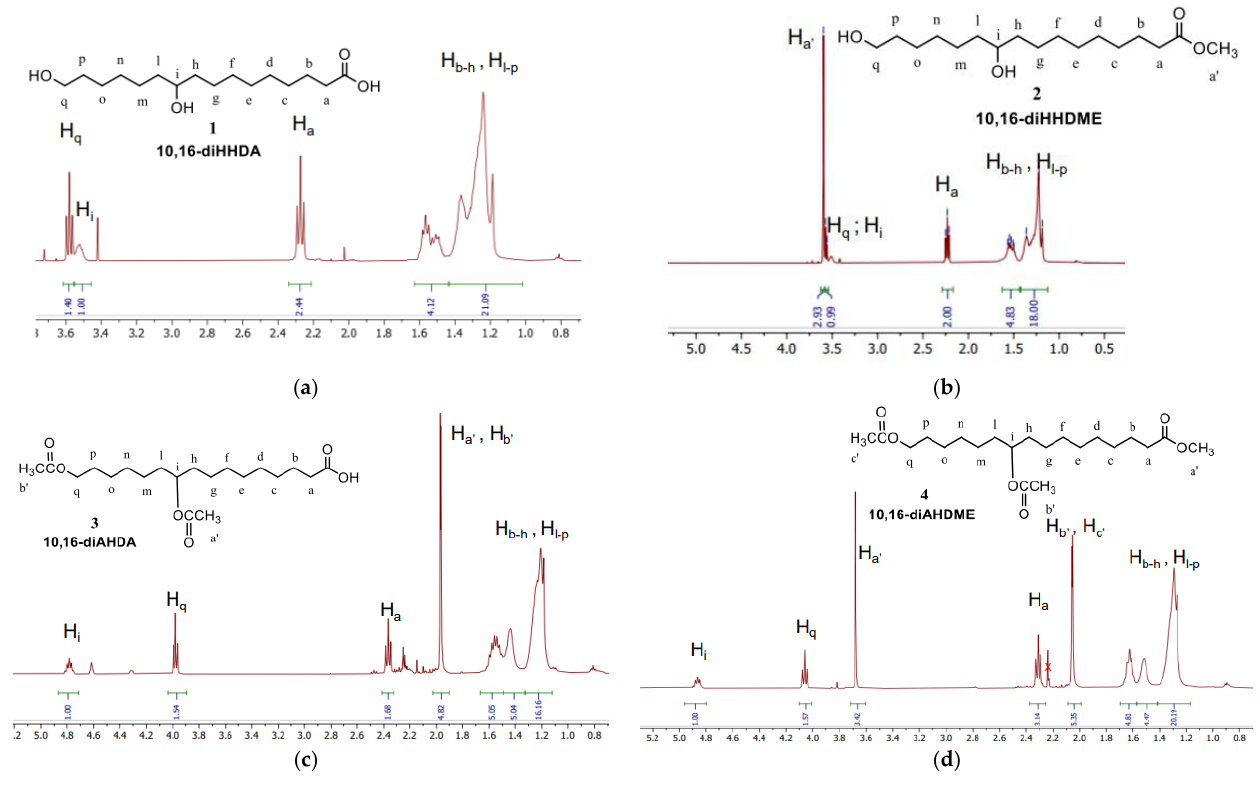
Figure 1. 1 H-NMR spectra in CDCl 3 of the synthesized compounds ( 1 – 4 ): ( a ) 1 H-NMR of 10,16- diHHDA ( 1 ); ( b ) 1 H-NMR of 10,16-diHHDME ( 2 ); ( c ) 1 H-NMR of 10,16-diAHDA ( 3 ); ( d ) 1 H-NMR of 10,16-diAHDME ( 4 ).